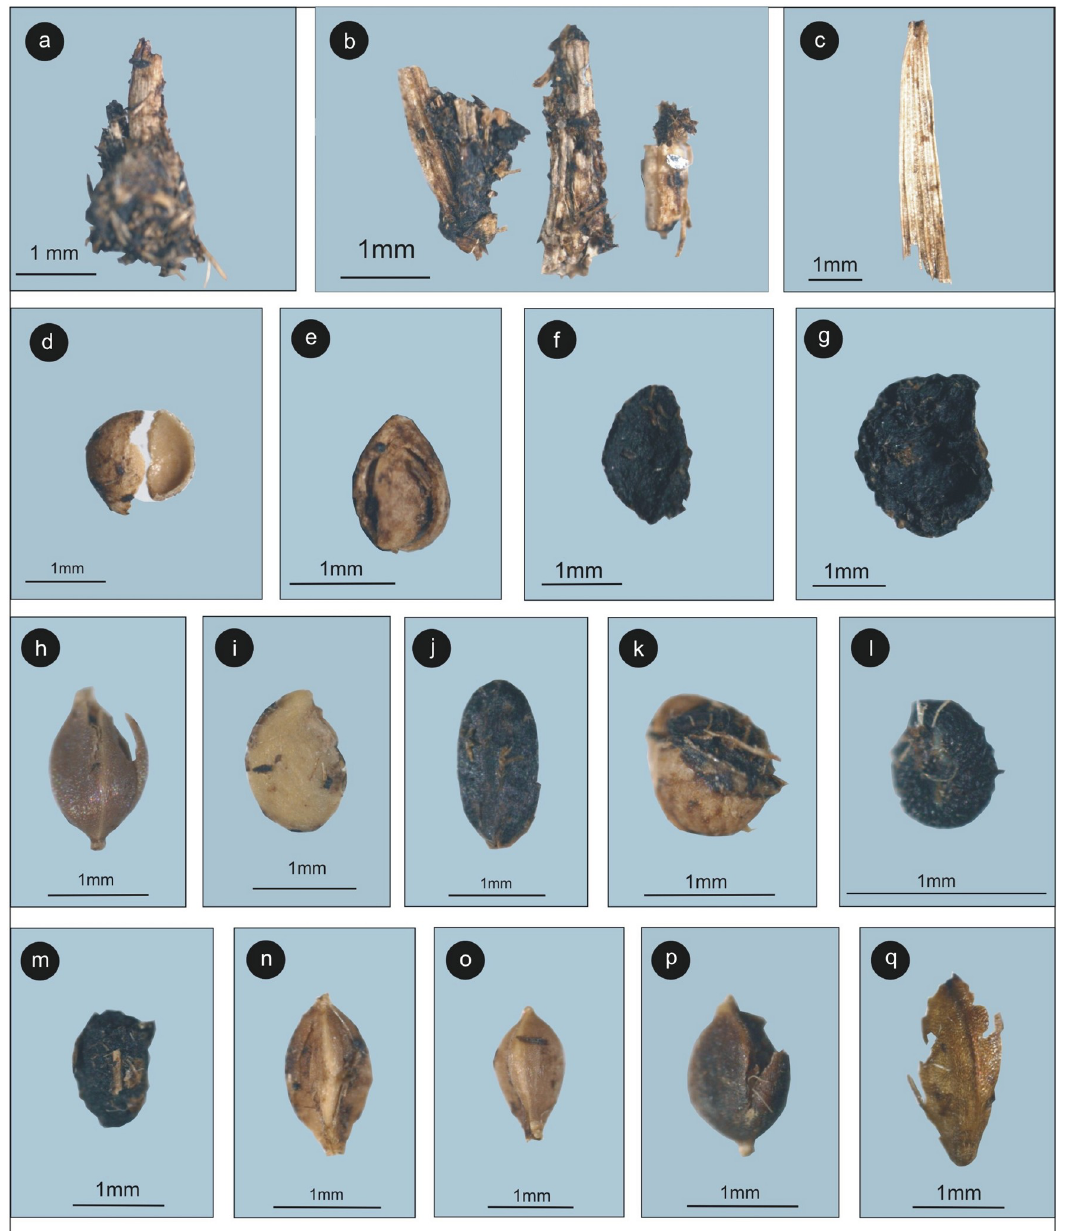
Fig 7. Macrobotanical assemblage recovered from the Yak dung samples. a. & b. plants parts including roots and stem of sedges/ herbaceous species, c. Monocot leaf, d. & e. Rosaceae, f. Liliaceae, g. Xanthoxylum sp., h. Polygonum , i. Solanum sp. (Solanaceae),